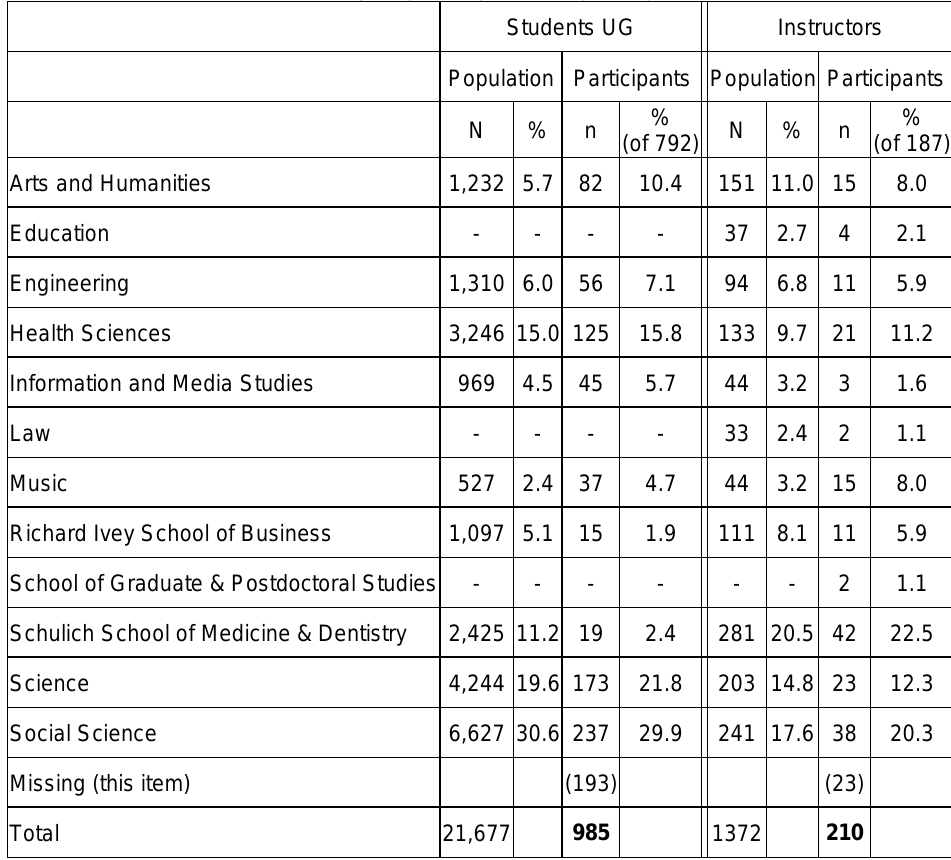
Table 1. Response numbers for Western students and instructors who indicated the faculty of their primary area of study or primary teaching